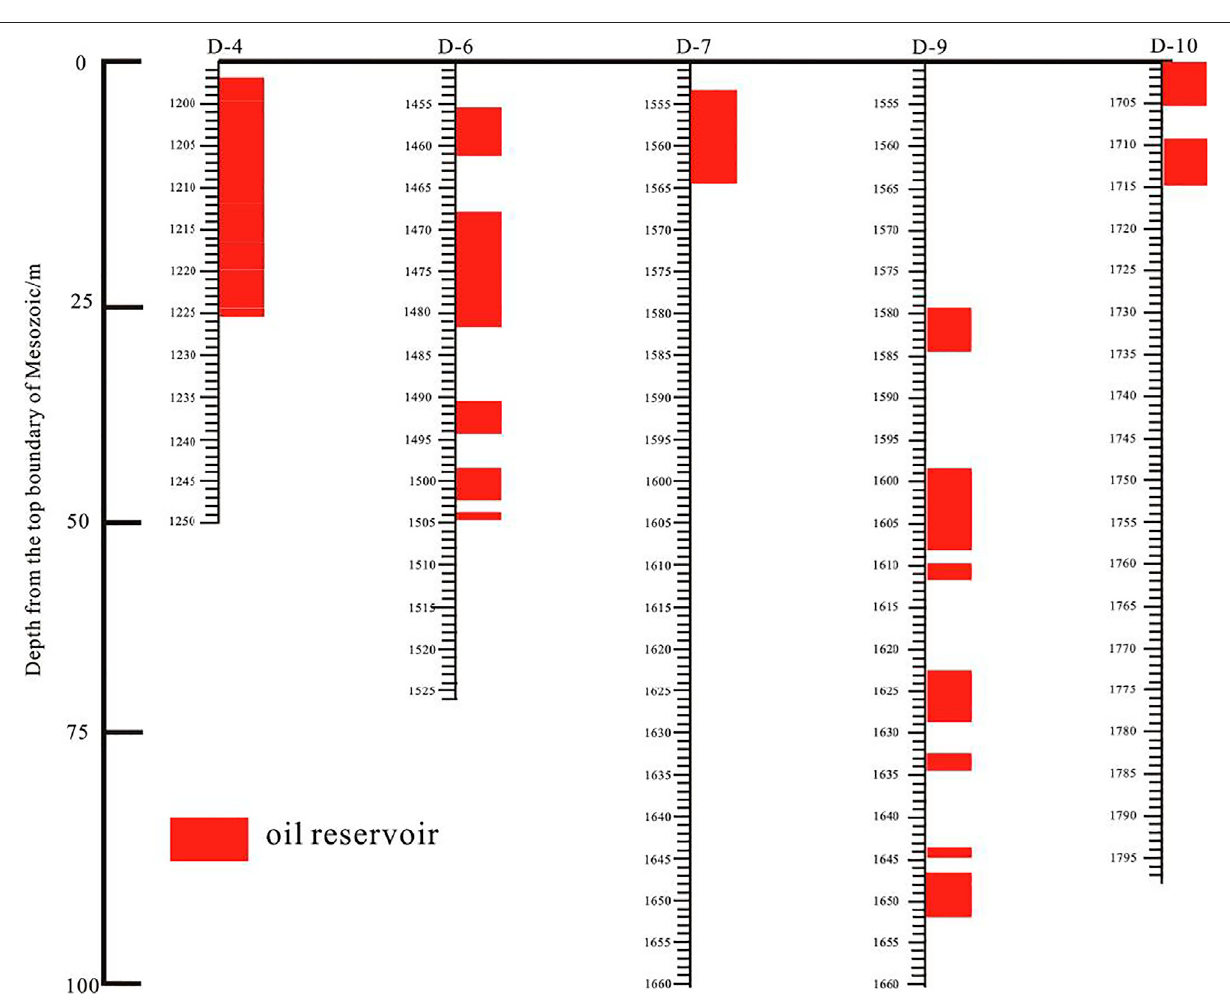
Frontiers in Earth Science |